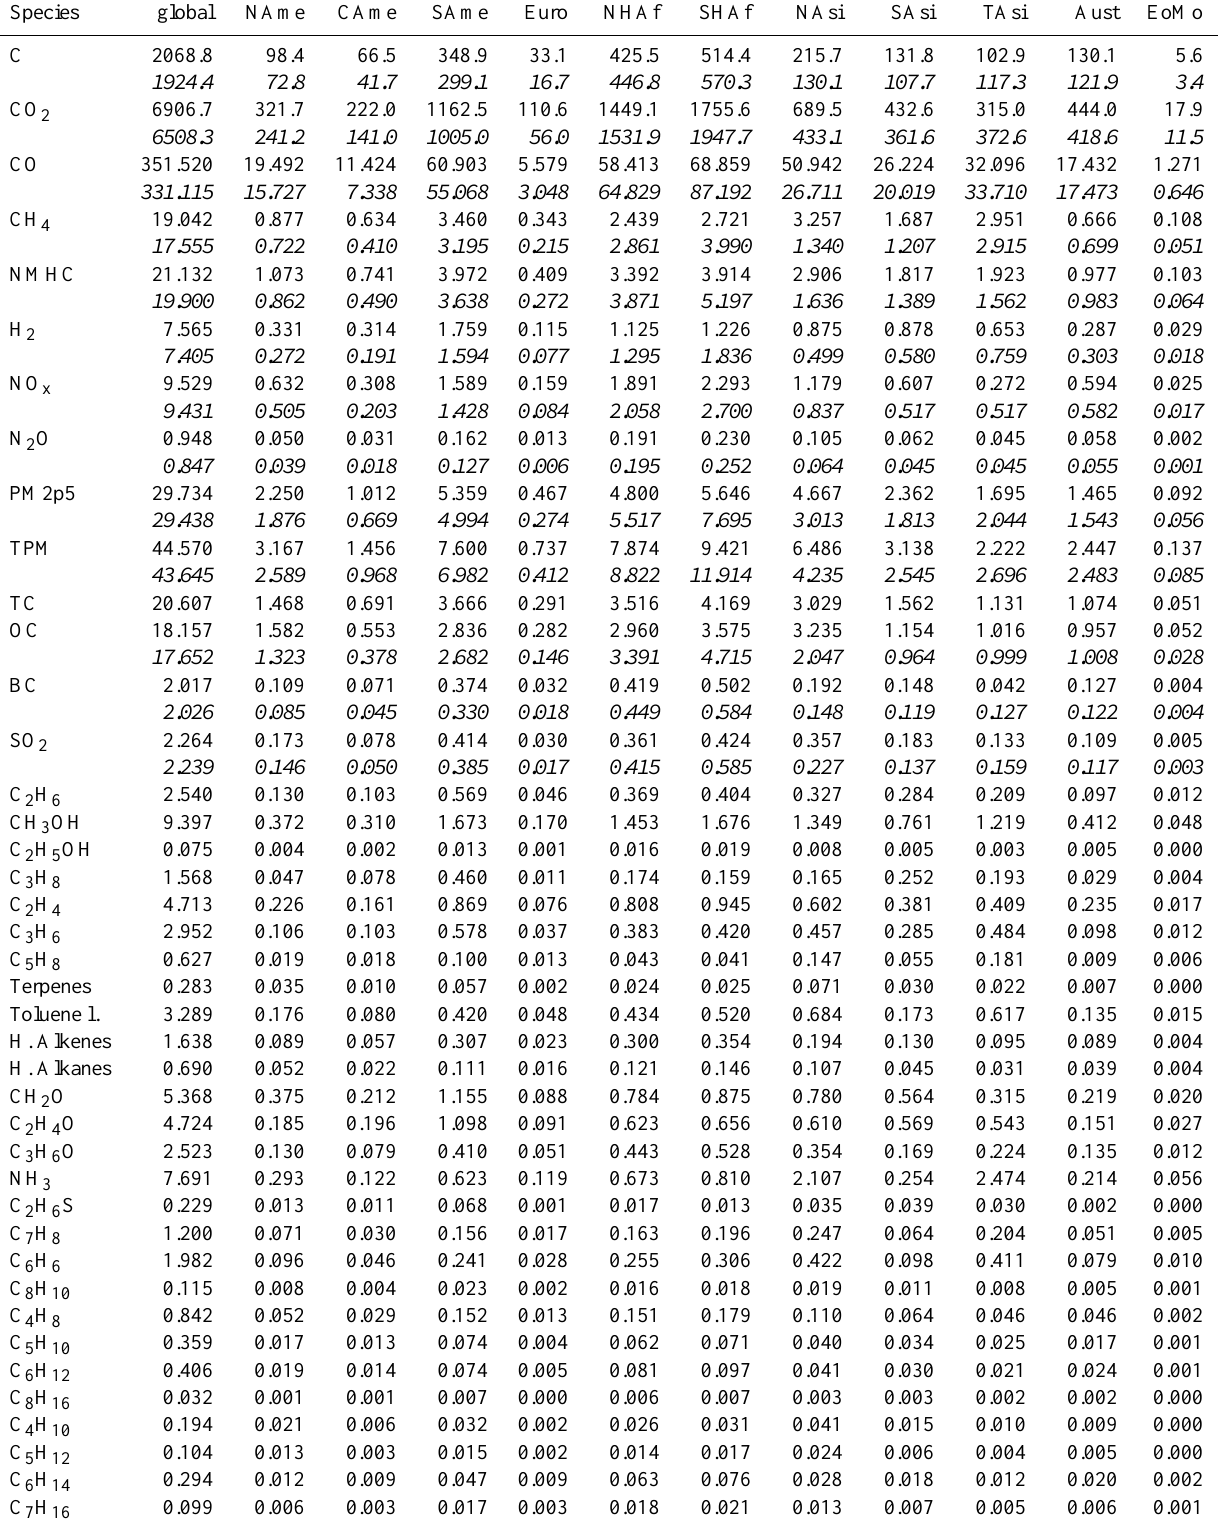
Table 5. Average annual emission [Tg] for the species defined in Table 3 in the regions defined in Table 4 from GFASv1.0 and GFED3.1. The GFED values are set in italics below the value for GFASv1.0 where available.